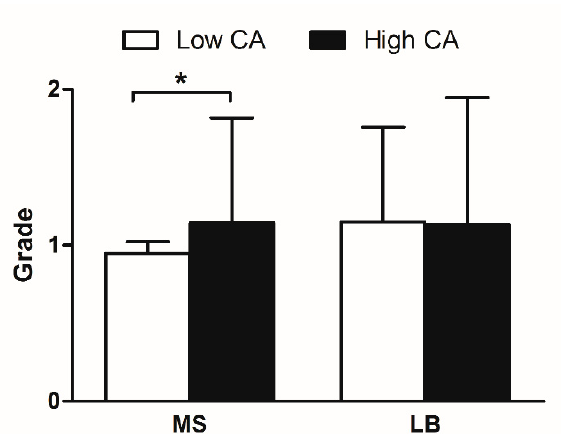
Figure 1. Presentation of microbiological test. Salivary levels of Mutans streptococci (MS) and Lactobacilli (LB) were recorded as follows; 0 = no or almost no CFUs, 1 = <10 5 CFU/mL, and 2 = ≥ 10 5 CFU/mL. Low CA; low caries-affected, High CA; High caries-affected * = statistically significant difference between the low CA and the high CA group (Mann–Whitney test, p < 0.05)